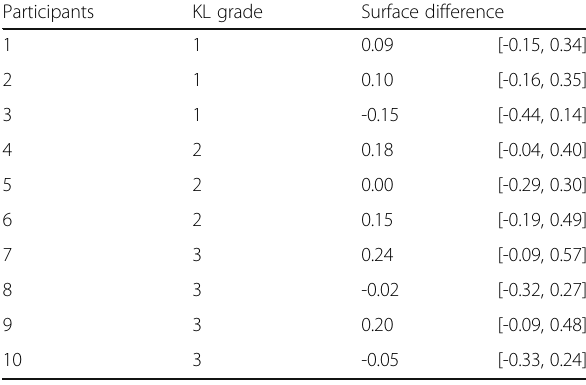
Table 3 Surface difference of the medial tibial plateau models